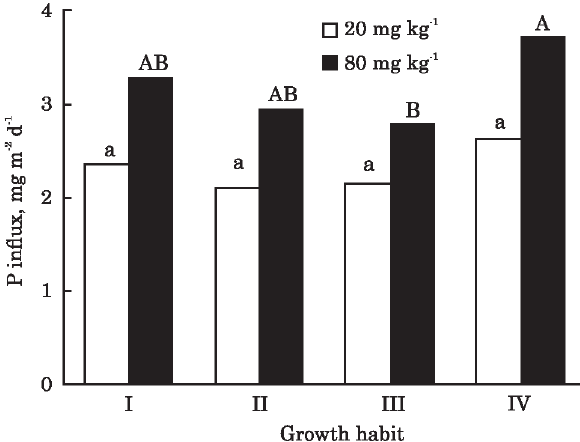
Figure 2. Influx of P into roots, estimated by the classical method of plant growth analysis (on root area basis) between the stages of pod setting and early pod filling, for 24 common bean genotypes grouped according to their growth habit, grown at two P levels applied to the soil (20 and 80 mg kg -1 ); means values signaled by the same letter do not differ by Tukey test at 5 %, lowercase letters comparing growth habits at low P level, and uppercase letters at high P level.